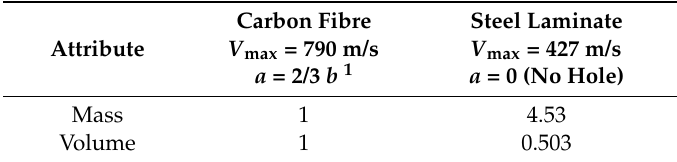
Table 1. Comparison of rotor mass and volume ratio of steel and composite.